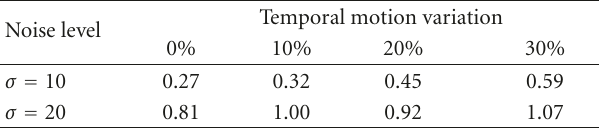
Table 3: Average of the global estimation error for di ff erent noise levels and di ff erent temporal motion variations (with 20% scatter